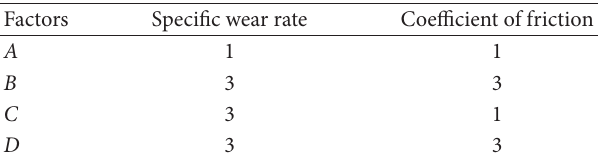
Table 7: Optimum factor